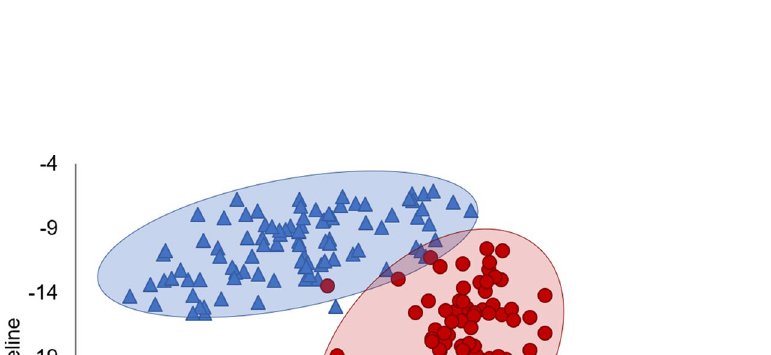
Table 4. PCA–LDA spectra classification and quality parameters for bovine plasma collected before and after the M. haemolytica challenge.